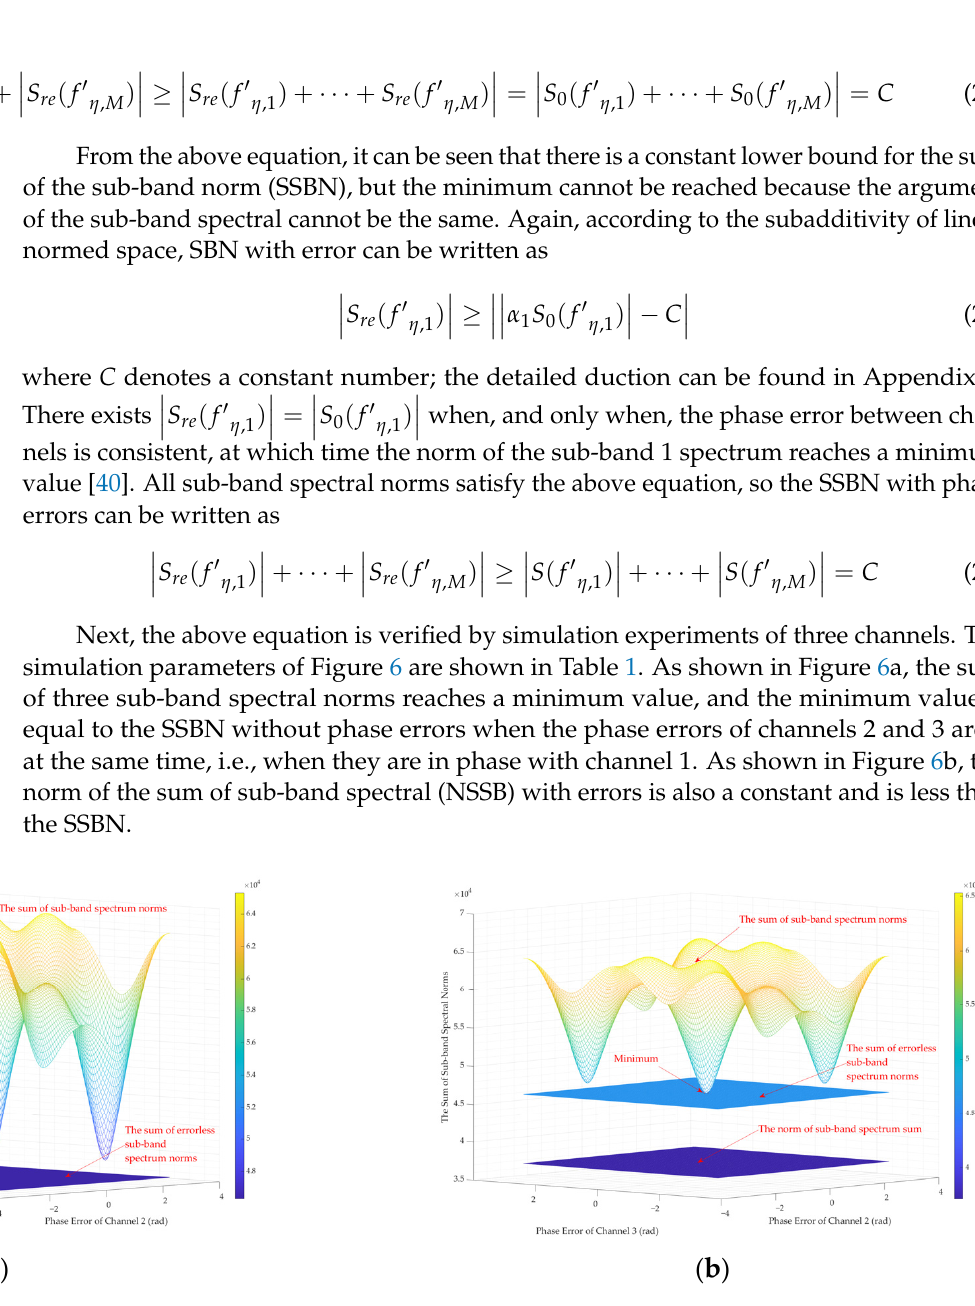
Figure 6. SSBN of the reconstructed spectrum with different phase errors. ( a ) SSBN has a minimum value when channel phase error is consistent. ( b ) The NSSB is smaller than the SSBN without phase error.